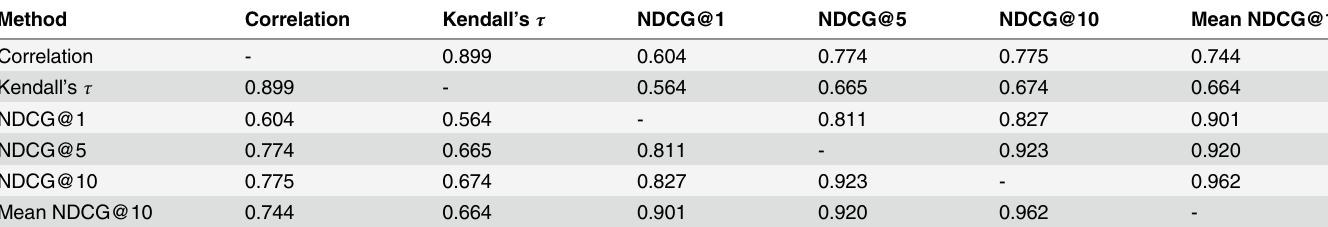
Table 8. Spearman ’ s rank correlation coefficient of evaluation measures averaged across 6